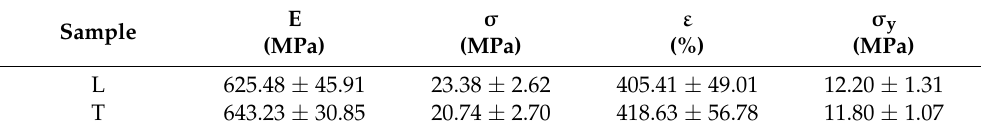
Table 3. Mean values and standard deviation for PFA specimens after tensile tests.